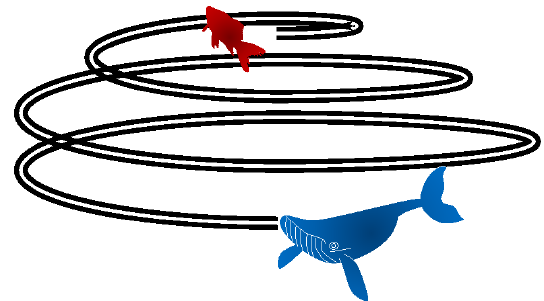
Figure 3. Bubble-net feeding technique of humpback